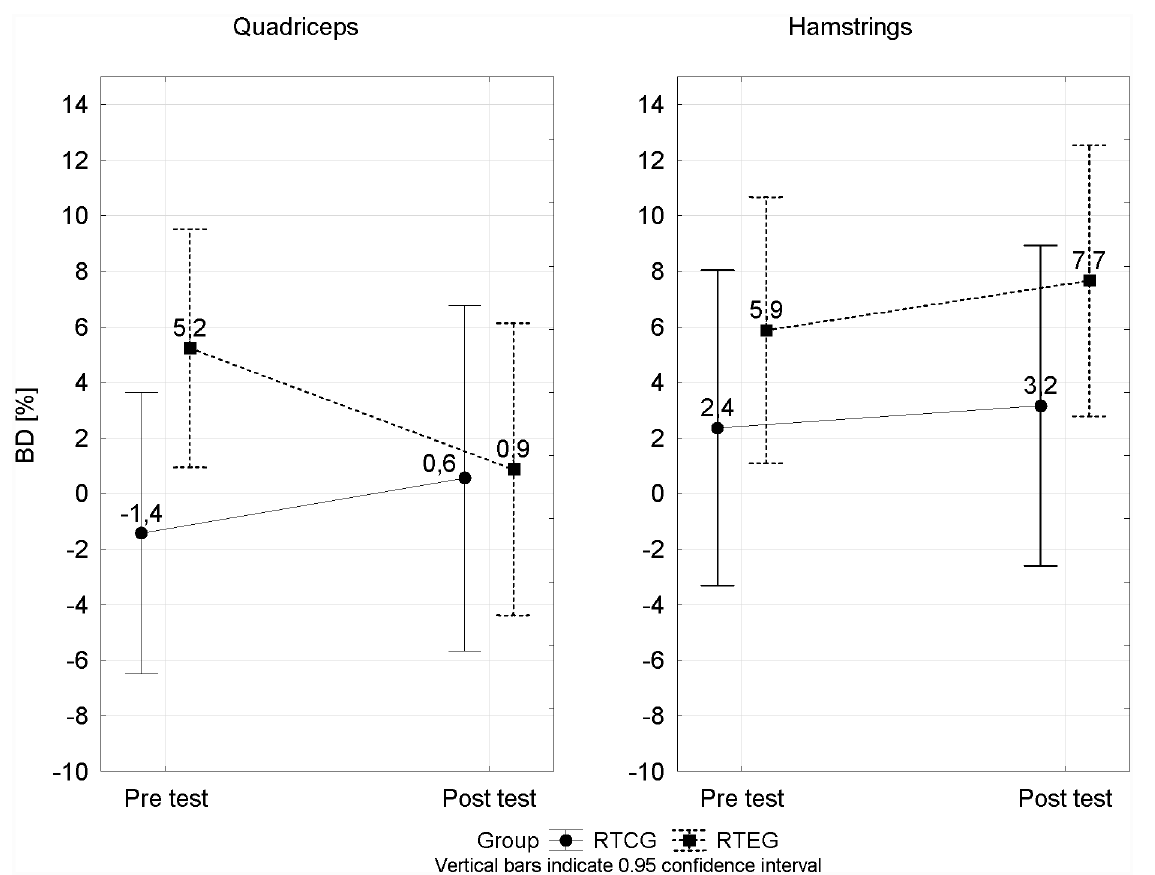
Fig 2. Comparison of changes in the BD between the pre- and post-tests in two Training Resistance Groups.